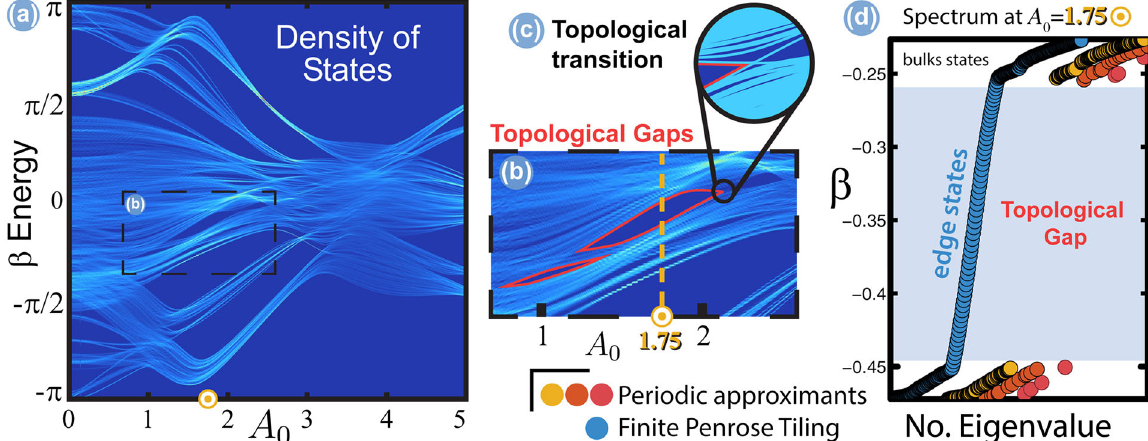
FIG. 4. (a) Density of states of the (periodic) Penrose tiling approximant, as a function of the strength of the vector potential A 0 . (b) Zoomed-in section of the region marked by the frame in (a). The gaps enclosed by the red line are topological. (c) Zoomed-in section marked by the circle in (b), showing the transition from a topological gap to a nontopological (trivial) gap. As A 0 is increased, the topological gap closes and a trivial gap opens up. (d) Energy spectrum around the topological gap for periodic approximants with increasing system size (red, orange, and yellow) and for a finite Penrose tiling (blue). The approximants are periodic; hence, they have a full band gap. On the other hand, the finite Penrose tiling has edge states whose energies reside in the topological